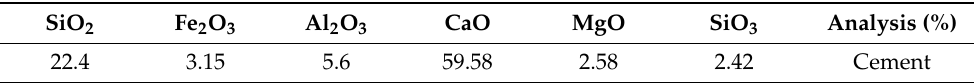
Table 1. Composition of the used Portland cement (wt %).